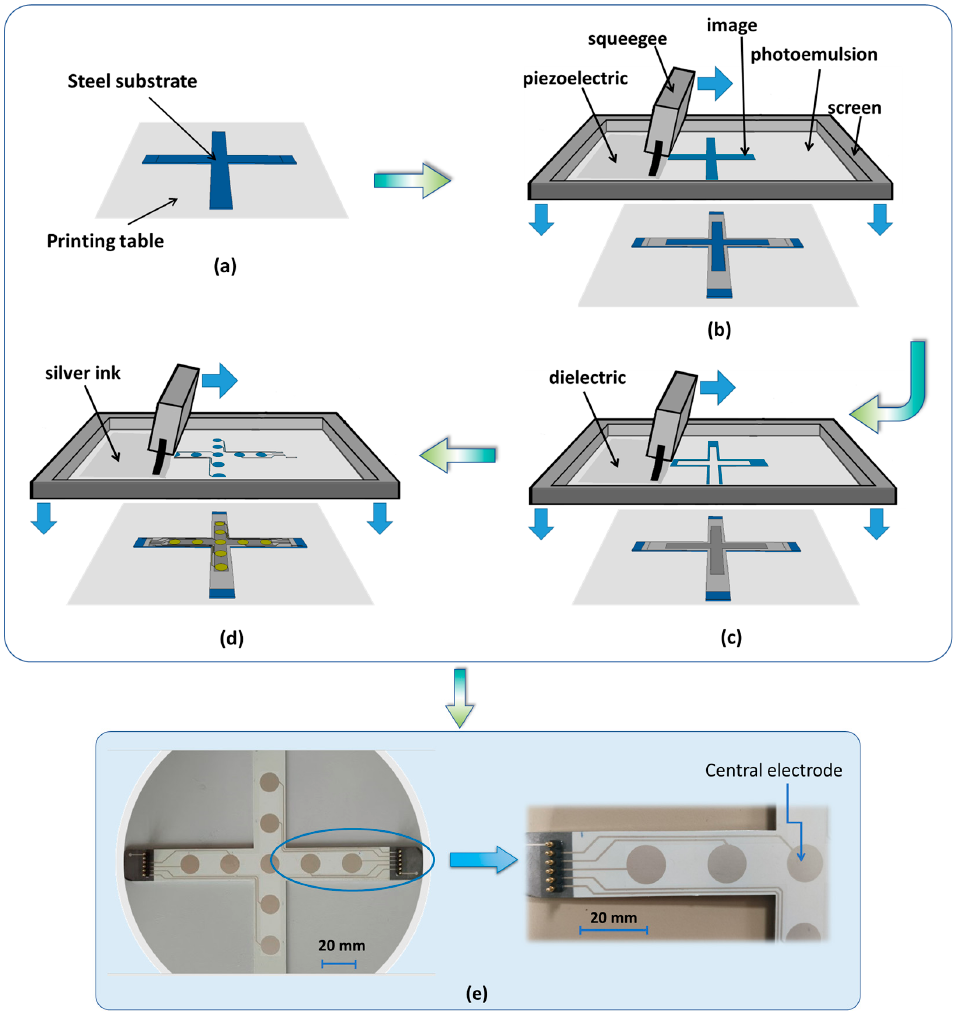
Figure 3. Fabrication of two-axis piezoelectric sensor via screen printing process: ( a ) setting steel substrate; ( b ) printing piezoelectric layer; ( c ) printing dielectric layer; ( d ) printing electrode and conductive tracks; and ( e ) full printed coating with electrical